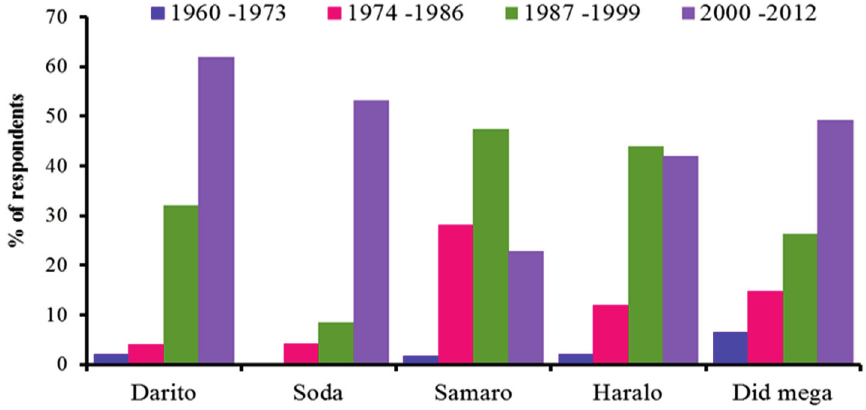
Figure 5. Comparison of temporal trends: increasing numbers of agro-pastoralists from 1960 to 2012 in